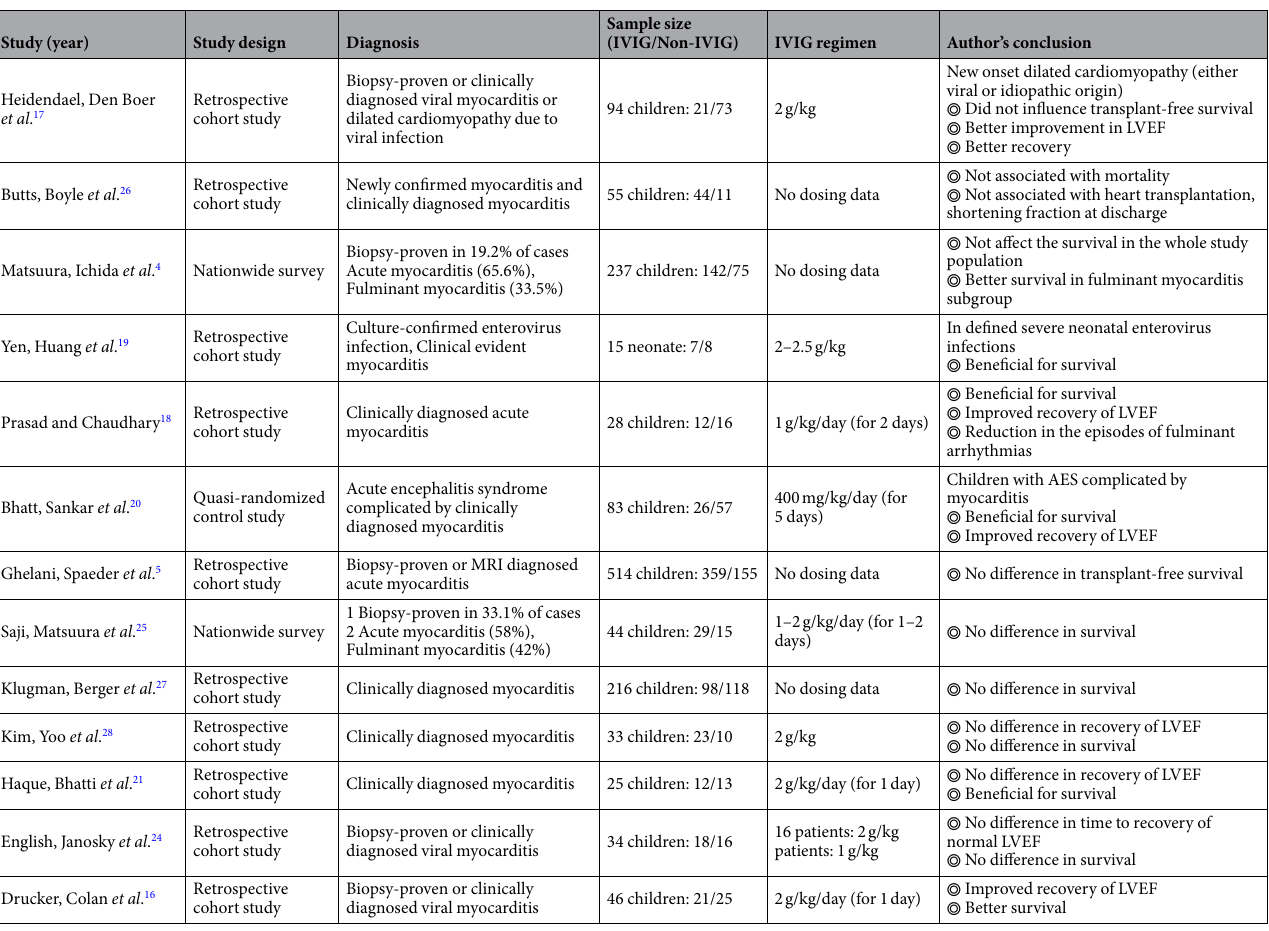
Table 1. Summary of the included studies. IVIG: intravenous immunoglobulin, LVEF: left ventricular ejection